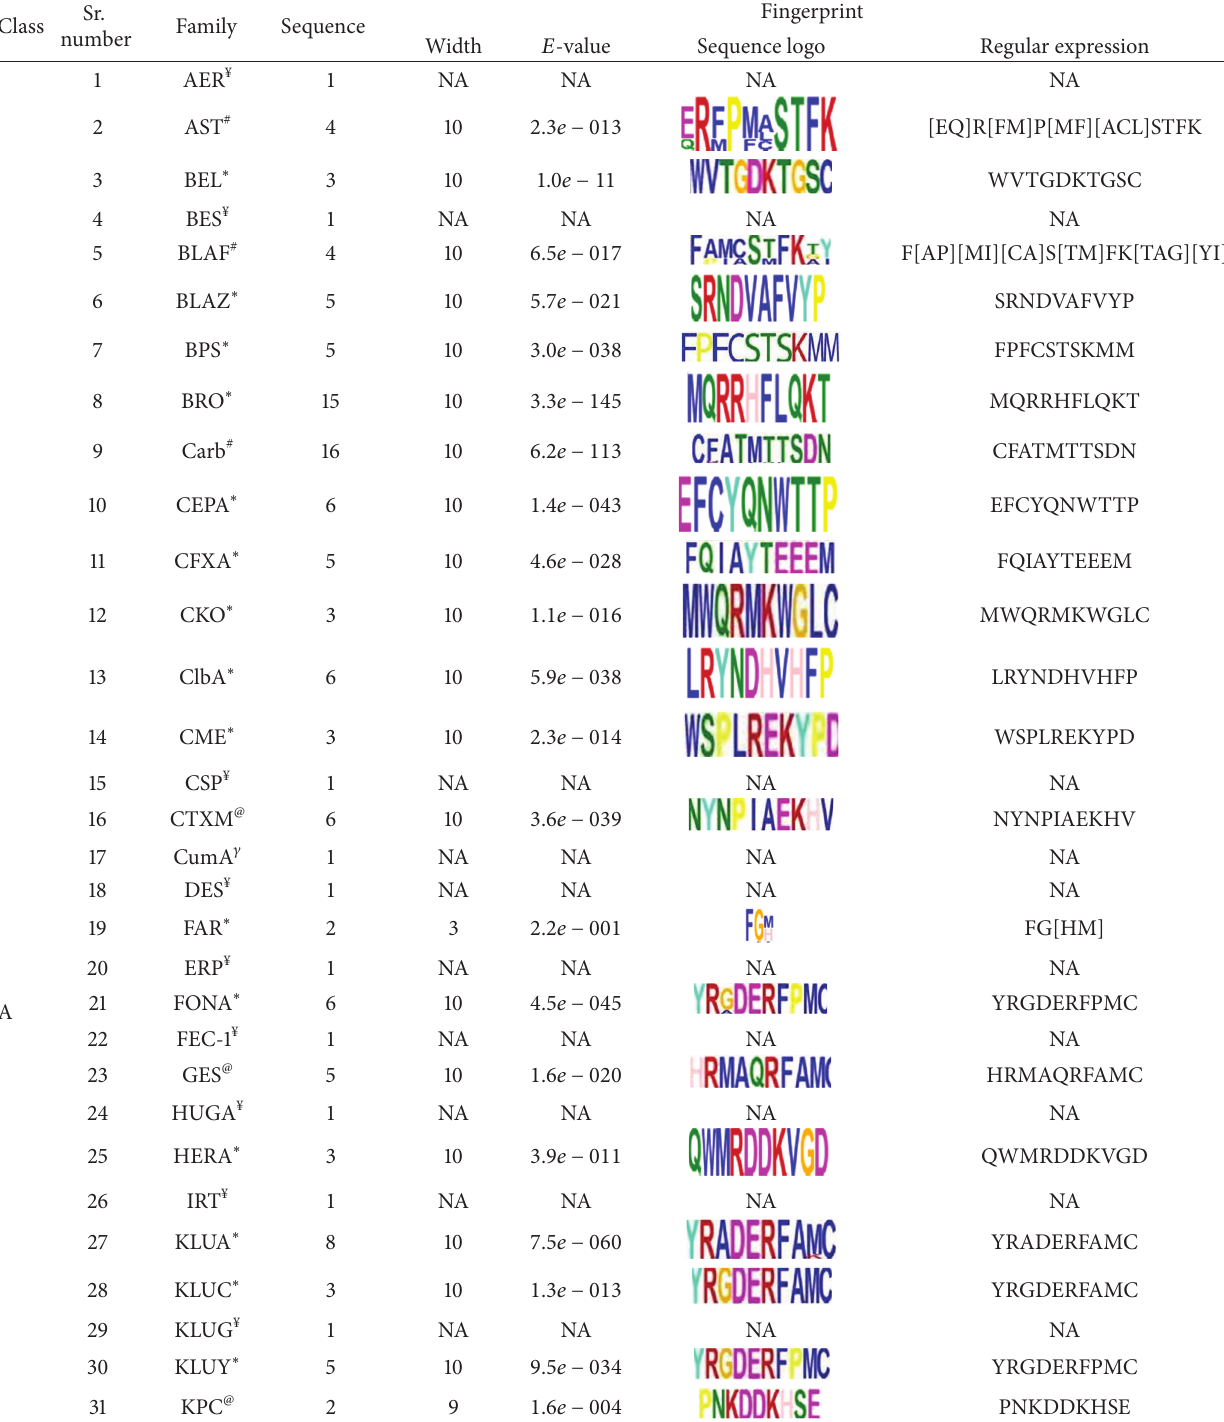
Table 1: List of fingerprints in different families of 𝛽 -lactamase. ( @ fingerprint is extracted from more than one sequence with evidence at protein existence level; # only one sequence has evidence at protein existence level, and hence proteins whose existence is not experimentally proven were also selected; ∗ only sequences without evidence of protein existence were present in the family, and hence fingerprint is based on nonexperimentally existence proteins; Ω only one sequence is present in the family with evidence of protein existence; ¥ only one sequence is present in the family whose existence is not proven at protein